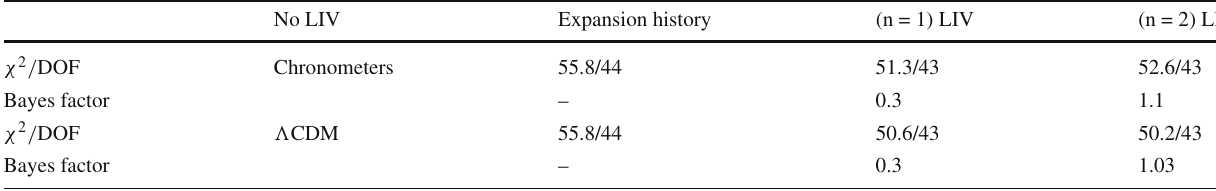
provide the χ 2 /DOF for all the three models, where DOF is equal to LIV for both the models and choices of expansion history. The χ 2